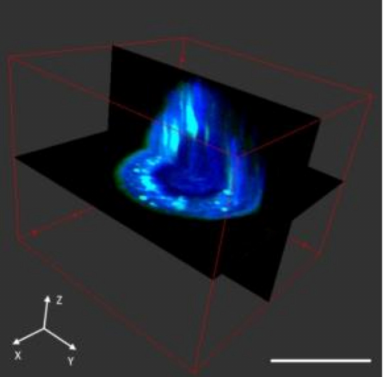
Figure 4. Three-dimensional volume reconstruction of a SKOV3 cell with z-stack Stimulated Raman Scattering (SRS) images taken with a depth interval of 0.2 µ m. The green and blue pseudo colors represent lipids (imaged at 2854 cm − 1 ) and proteins (imaged at 2930 cm − 1 ), respectively. Scale bar: 20 µ m. The 3D display was rendered using